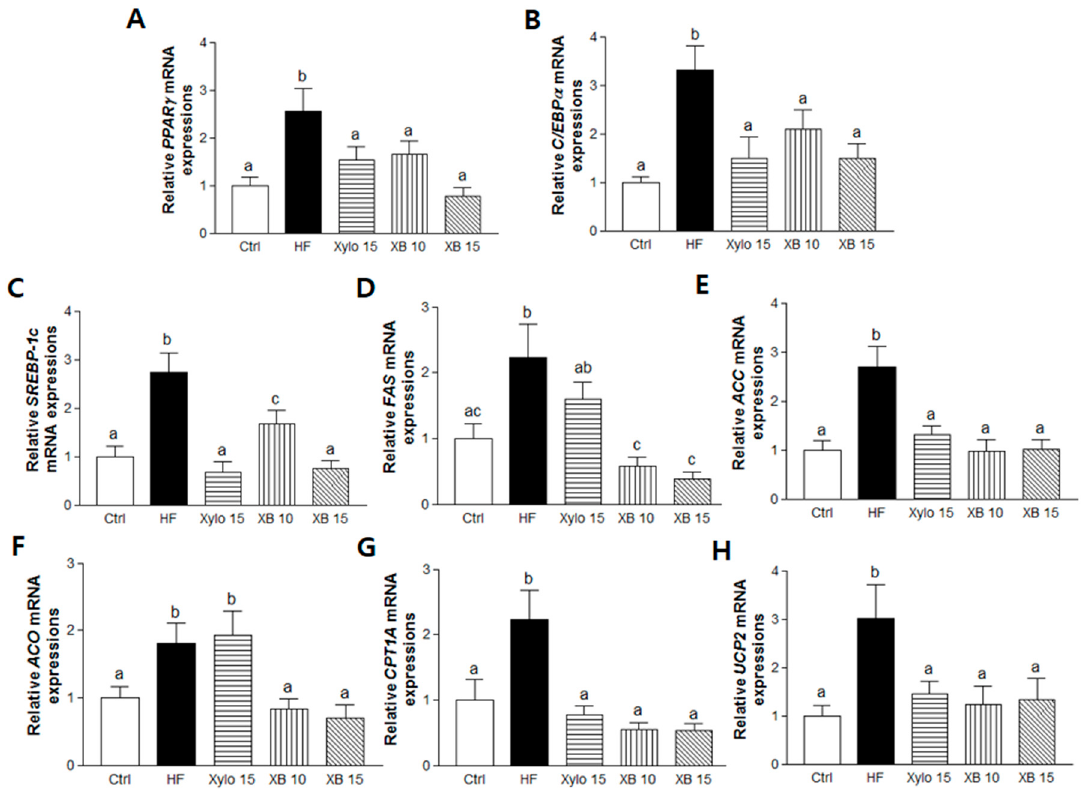
Figure 2. Effects of XB on the expressions of genes related to adipogenesis, lipogenesis, and energy metabolism in mesenteric adipose tissue. Real-time PCR was performed to detect mRNA levels of adipogenesis and lipogenesis-related genes in mesenteric adipose tissues. ( A ) PPAR γ ; ( B ) C/EBP α ; ( C ) SREBP-1c ; ( D ) FAS ; ( E ) ACC and β -oxidation-related genes; ( F ) ACO ; ( G ) CPT1A ; and ( H ) UCP2. Detection of GAPDH was performed as a loading control. The values presented are the mean ± SEM and all of the data were analyzed with one-way ANOVA and Newman-Keuls’ post hoc test. The superscript letters indicate significant differences ( p < 0.05). PPAR γ , peroxisome proliferator-activated